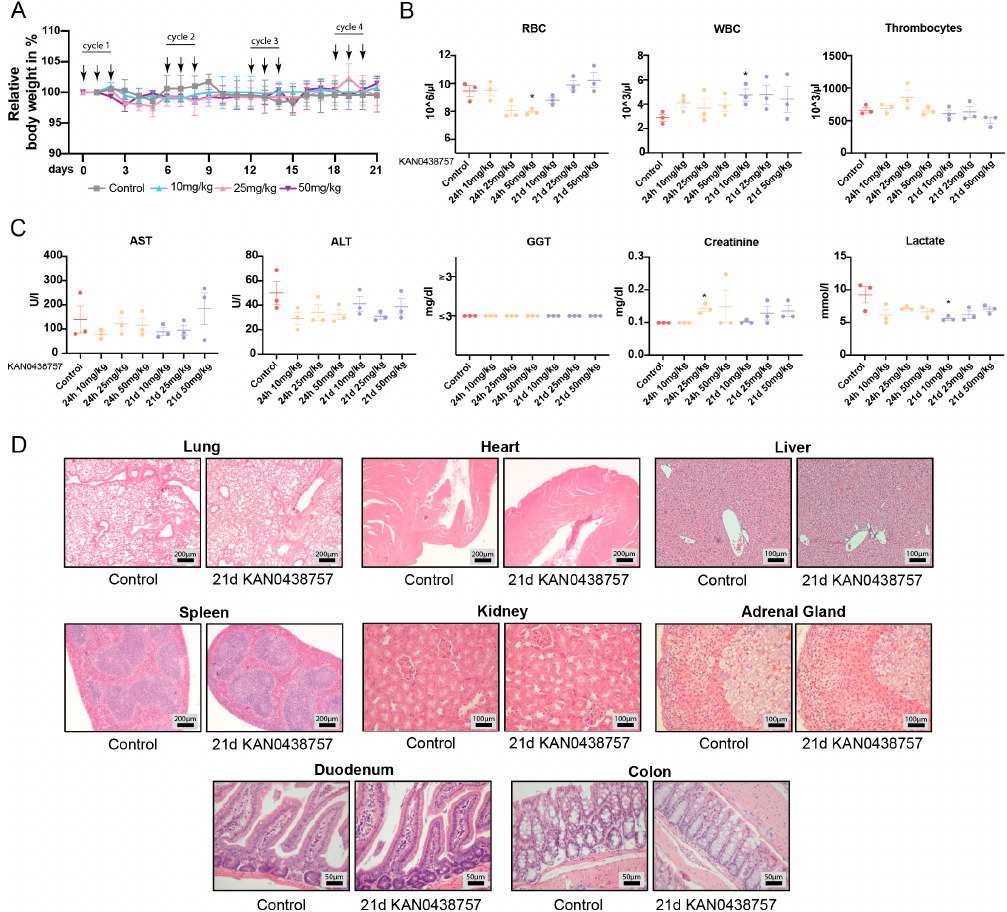
Figure 7. In vivo toxicity testing of KAN0438757 in immune-competent mice. ( A ) Relative weight curves of C57BL6/N mice treatment with 10 mg/kg ( n = 3), 25mg/kg ( n = 3) and 50 mg/kg ( n = 3) KAN0438757 (arrows, i.p. injections). Control, DMSO ( n = 3). ( B , C ) Whole blood counts (RBC, WBC, thrombocytes) and serum biochemical evaluation of aspartate transaminase (AST), alanine transaminase (ALT), gamma-glutamyl transferase (GGT), creatinine and lactate after treatment periods of 24 h to 21 days with KAN0438757. ( D ) Representative pictures of histological analysis (H&E) of lungs, heart, liver, spleen, kidneys, adrenal glands, duodenum and colon from mice treated 21 days (21 d) with KAN0438757 (25 mg/kg dosage). * p < 0.05; Data is ±